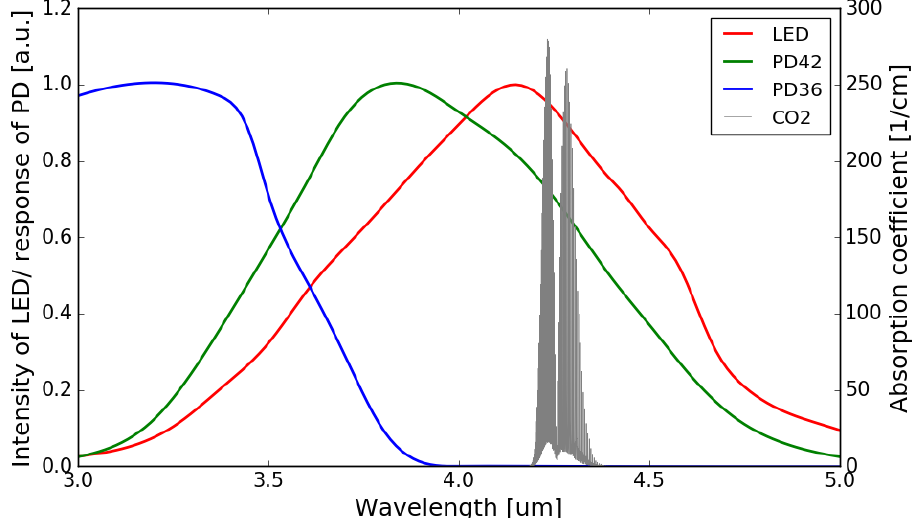
Figure 4. Normalized emission spectrum of the LED (data extrapolated from [22]) and spectral responses of the photodiodes (data extrapolated from [22,23]) with the absorption spectrum of CO 2 in the 3–5 µ m wavelength range (Adapted with permission from ref. [24]. Copyright 2013